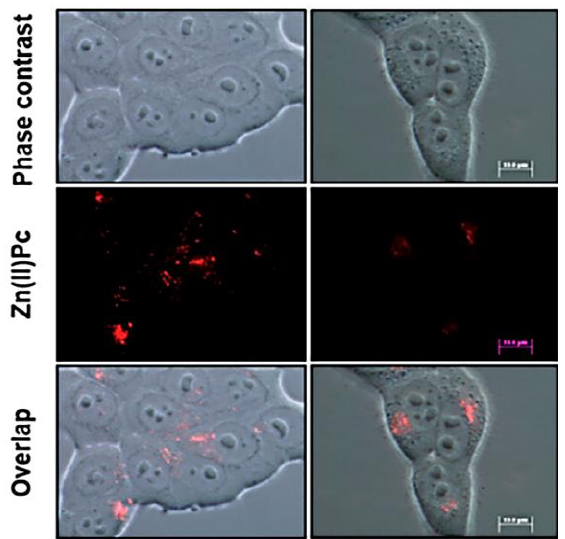
Figure 12. Cellular localization study of compound 51 in SCC-13 ( left ) and HeLa cells ( right ). Fluorescence microscopy conducted with green-light irradiation at 545 nm using a BP545 filter. Figure used with permission from [51]. Copyright 2020 Revuelta et al.